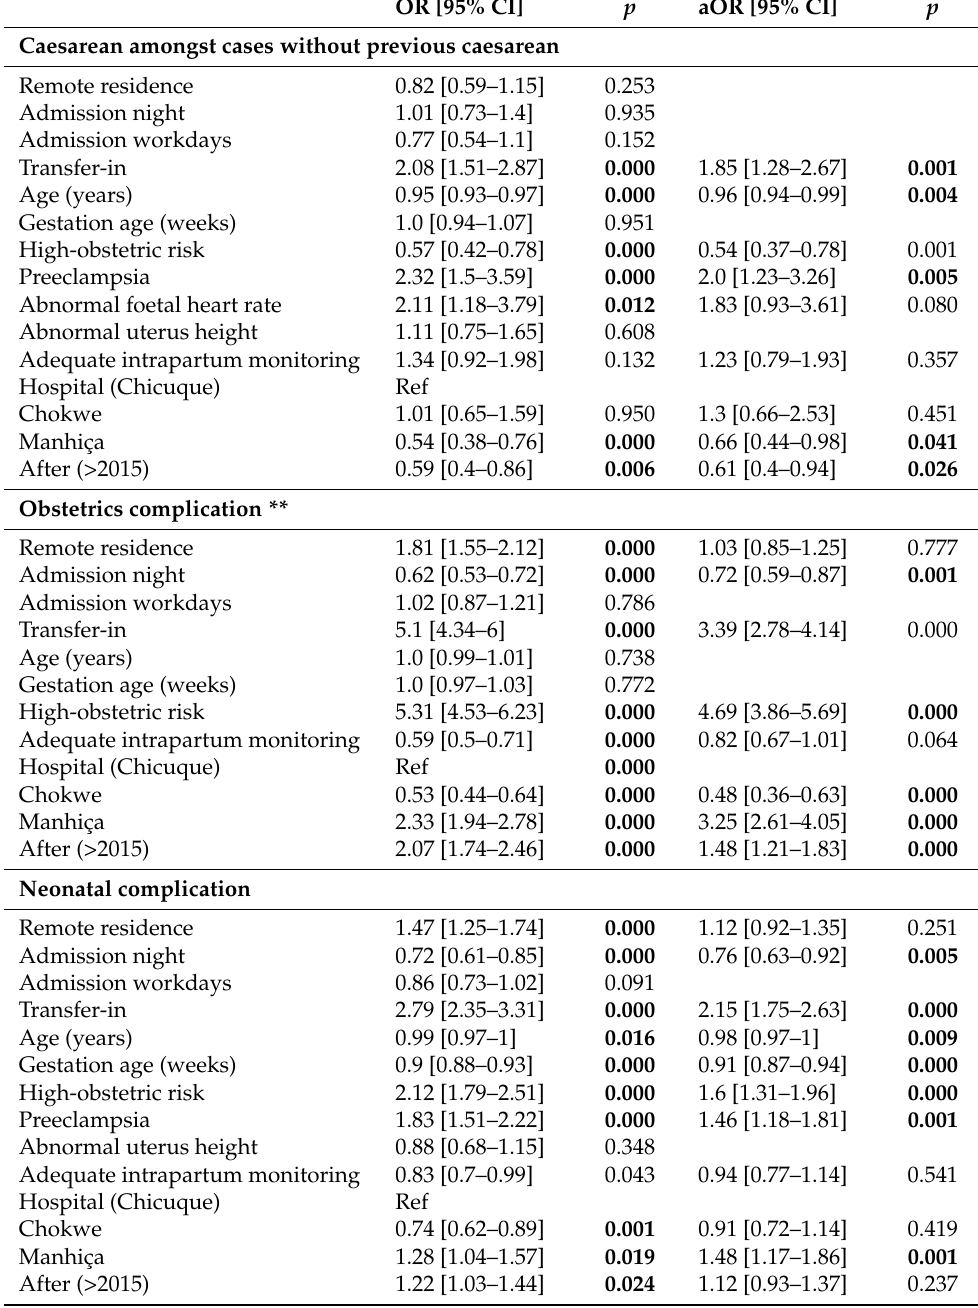
Table 3. Factors associated with caesarean, maternal and neonatal